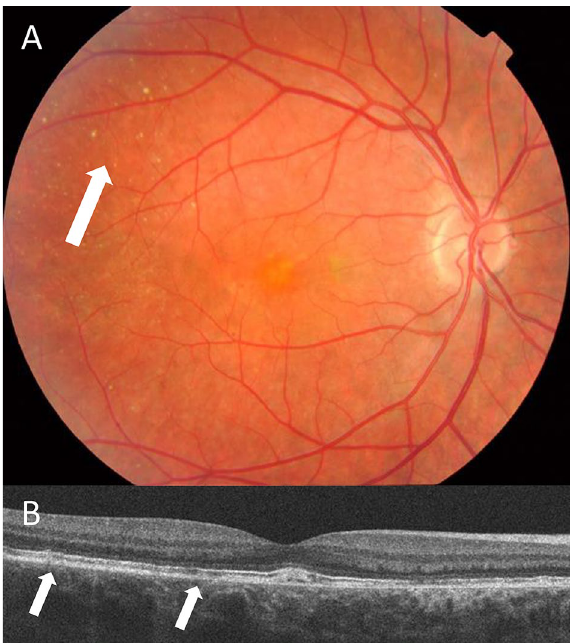
Figure 2. Retinal view of the central retina in an individual with IgA glomerulonephritis and ulcerative colitis demonstrating drusen ( A ) that are visible between the retinal pigment epithelium and Bruch’s membrane on optical coherence tomography (OCT, B